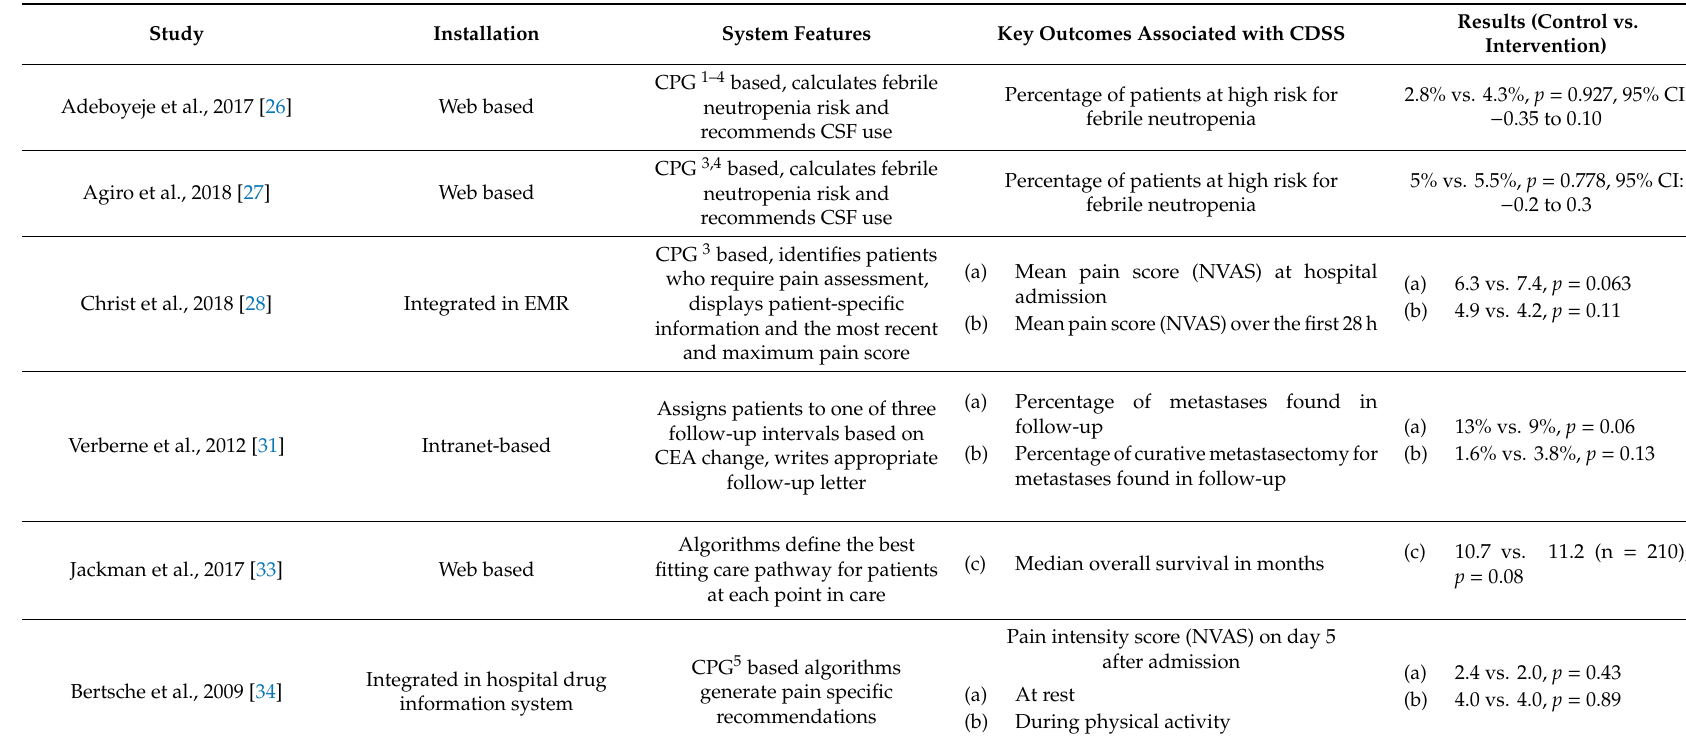
Table 4. Impact of CDSS on Clinical